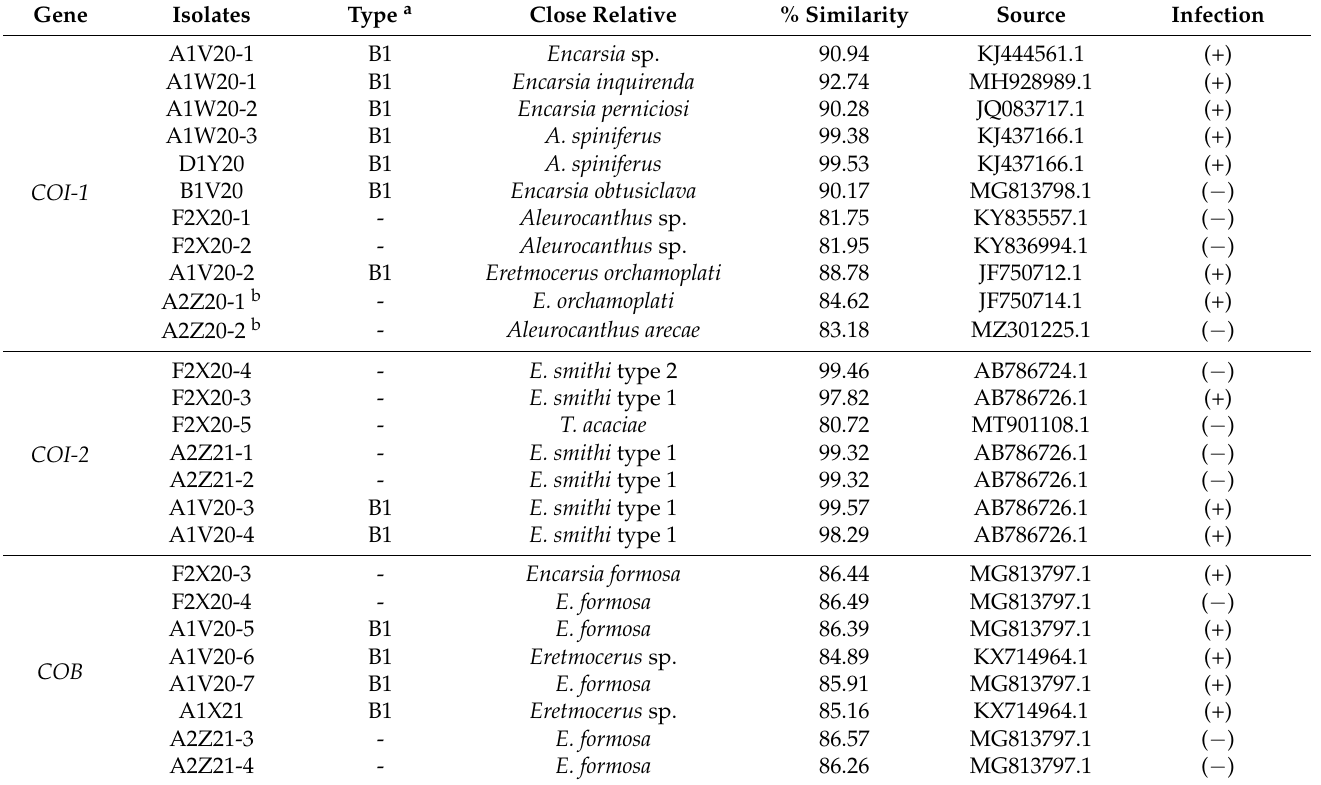
Table 2. Identification of mitochondrial genes using BLAST and the Wolbachia infection